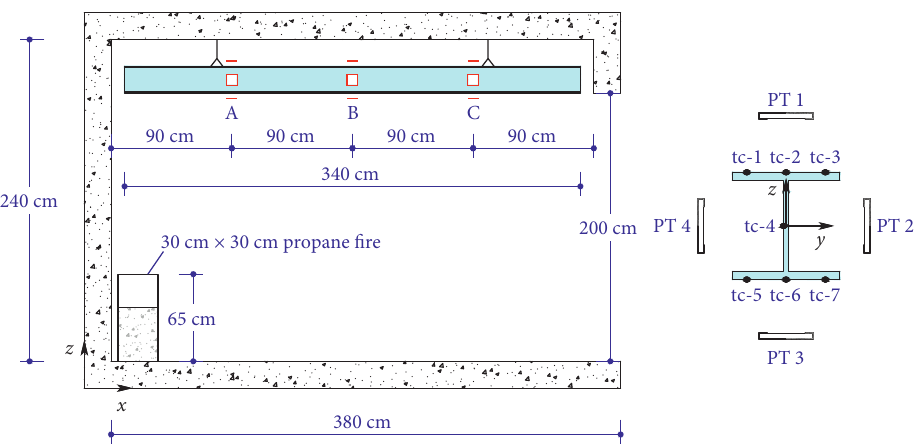
Figure 1: Configuration of Test 3 conducted by Wickstr¨om et al.